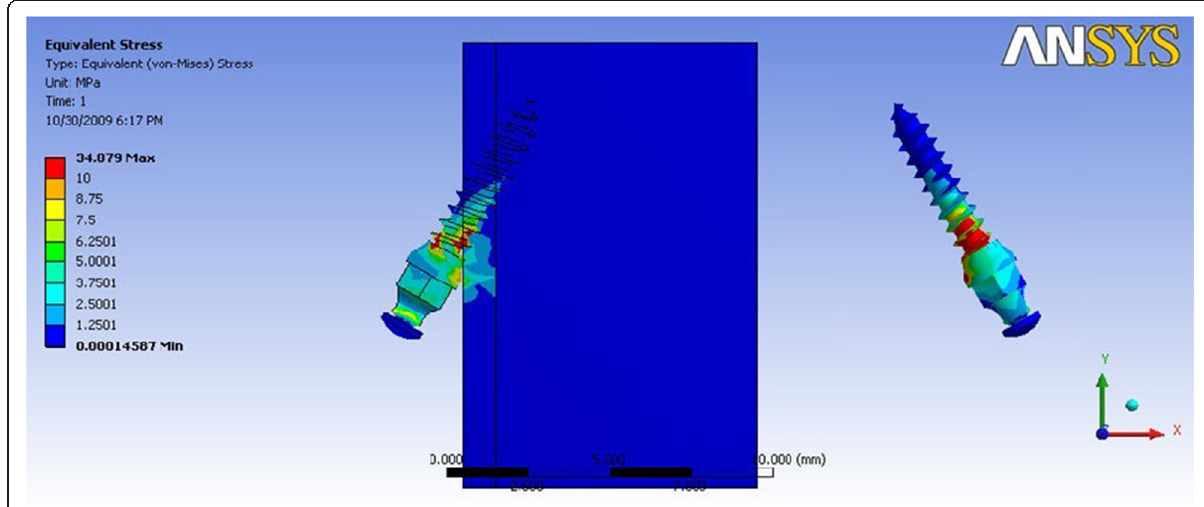
Fig. 3 von Mises stress distribution for mini-implant group 1a — anterior retraction: von Mises stress distribution seen at the bone-implant interface and in the mini-implant alone. Maximum stress seen in the mini-implant was at 34.82 MPa